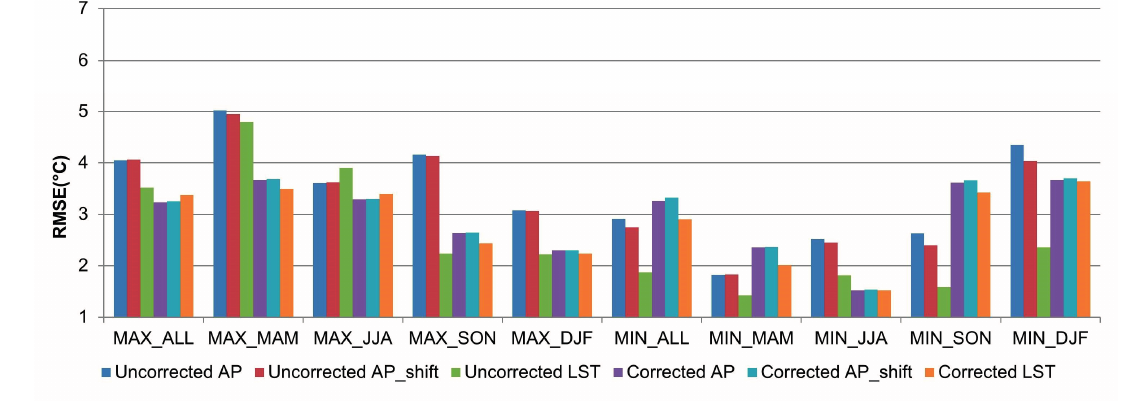
Figure 8. RMSE values averaged for 60 ASOS weather stations’ locations for estimating monthly air temperature with or without the correction using the NCEP/NCAR reanalysis data (unit: